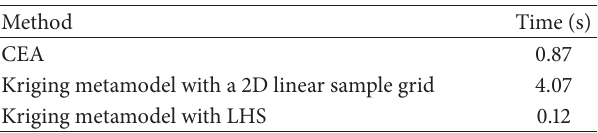
Table 12: Comparison of computation time between the CEA and the metamodel for three parameters. Method CEA Kriging metamodel with LHS 0.67 Table 13: Comparison of the number of samples for each of the case studies p = {𝜇,𝑘 11 } and p = {𝜇,𝑘 11 ,𝑘 22 } (i.e., for 2 or 3 parameters) inordertocomputethedeterministicresultsviaCEAortoconstruct a kriging metamodel. Deterministic method Kriging based on a 2D linear sample